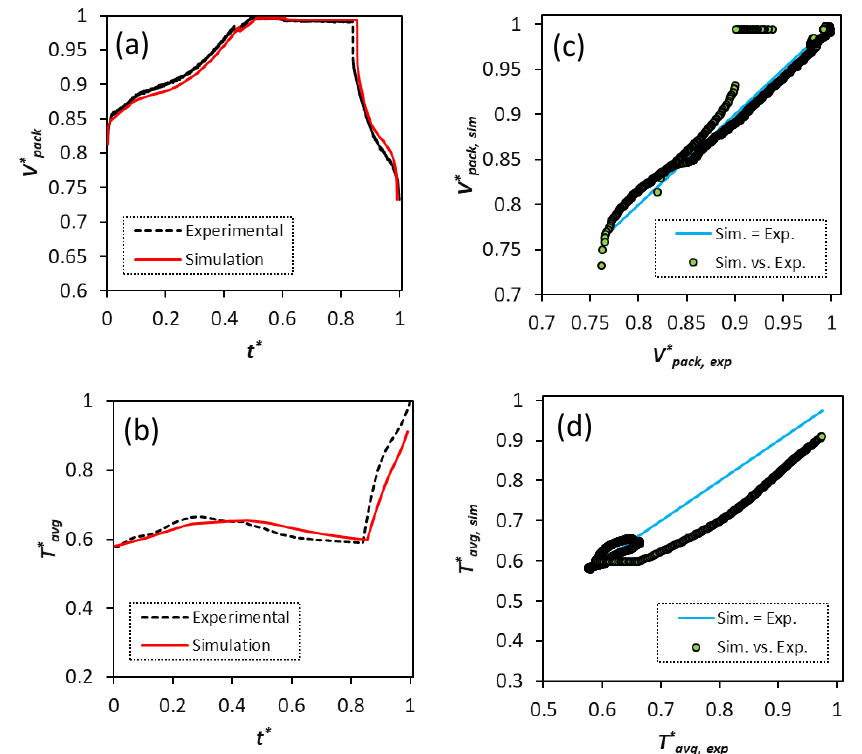
Figure 9. Lumped pack model calibration optimization results for the first scenario (C/2 + C/3 CC charge, CV charge, rest, 1.5 C discharge). ( a ) Pack terminal voltage; ( b ) pack average temperature; ( c , d ) point by point comparison between the simulations and experiments for the pack terminal voltage and average